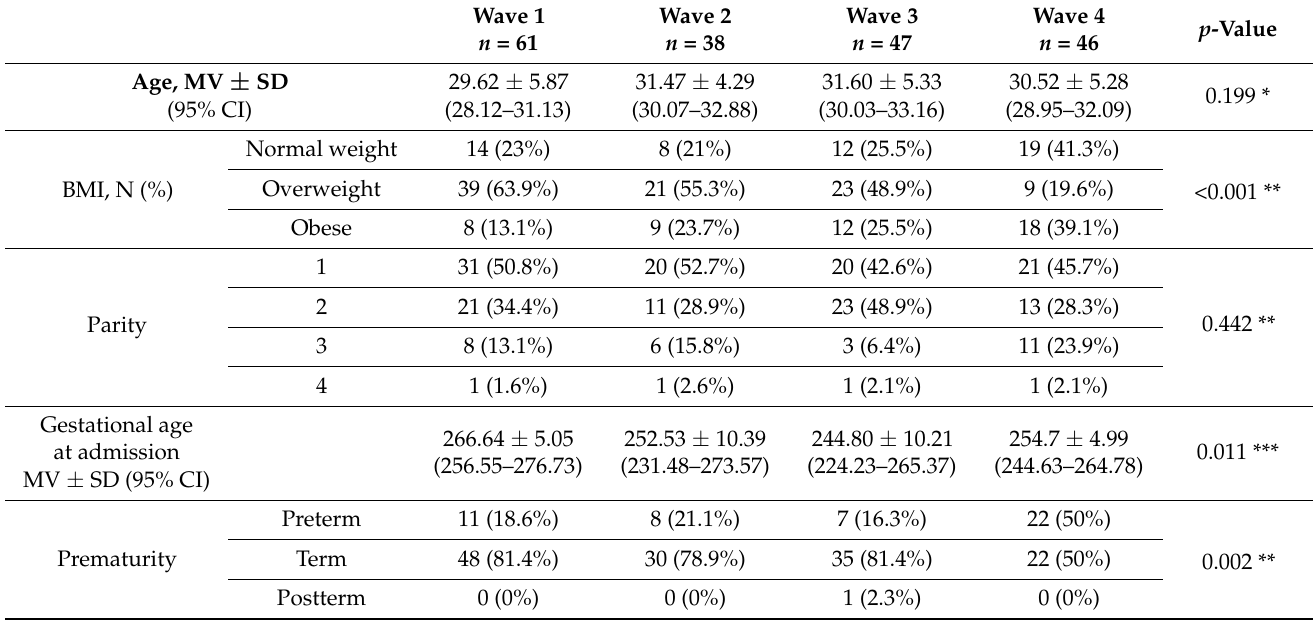
Table 1. Distribution of maternal and newborn parameters, and obstetrical characteristics regarding the epidemic